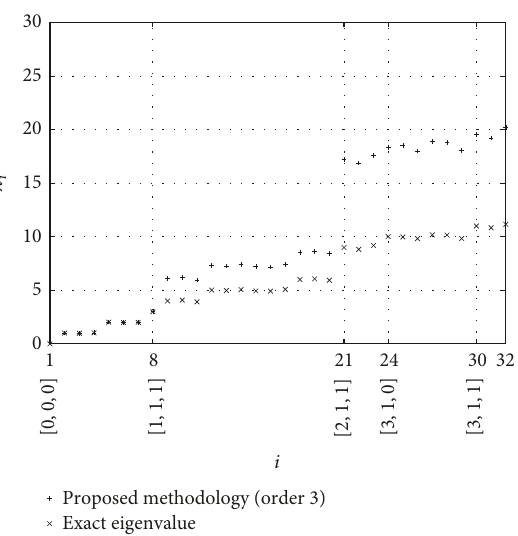
Figure 4: Cube: 𝑝 -convergence of